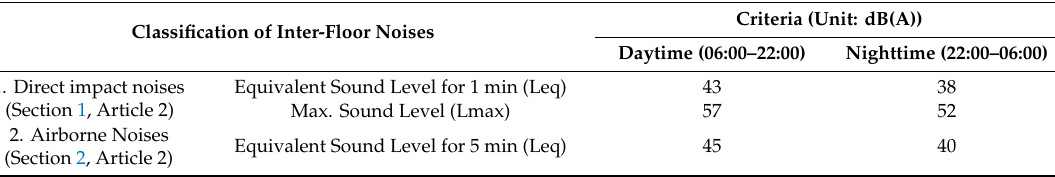
Table 4. Regulations on the limits and criteria with regard to inter-floor noises in apartment and multiplex houses: Inter-floor